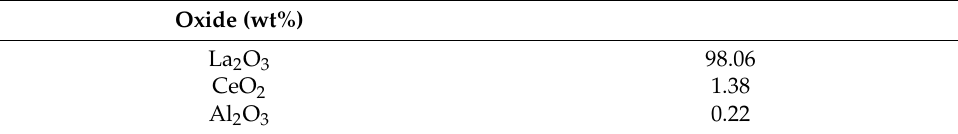
Table 5. Chemical composition (wt%) for the obtained lanthanum oxides.